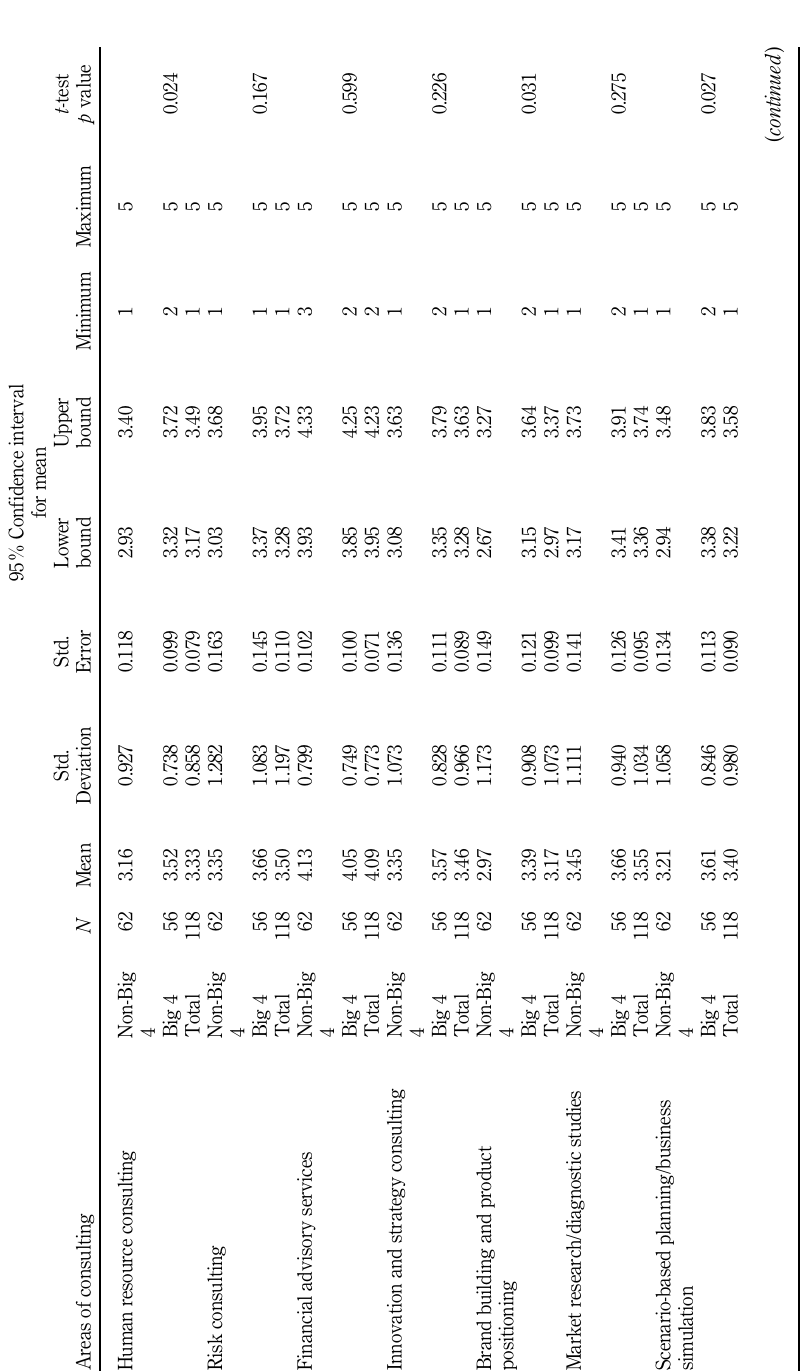
Table 12. Level of BDA usage in various areas of